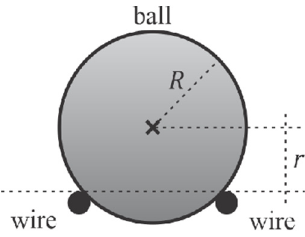
Figure 5. Graphic representation of the radius.